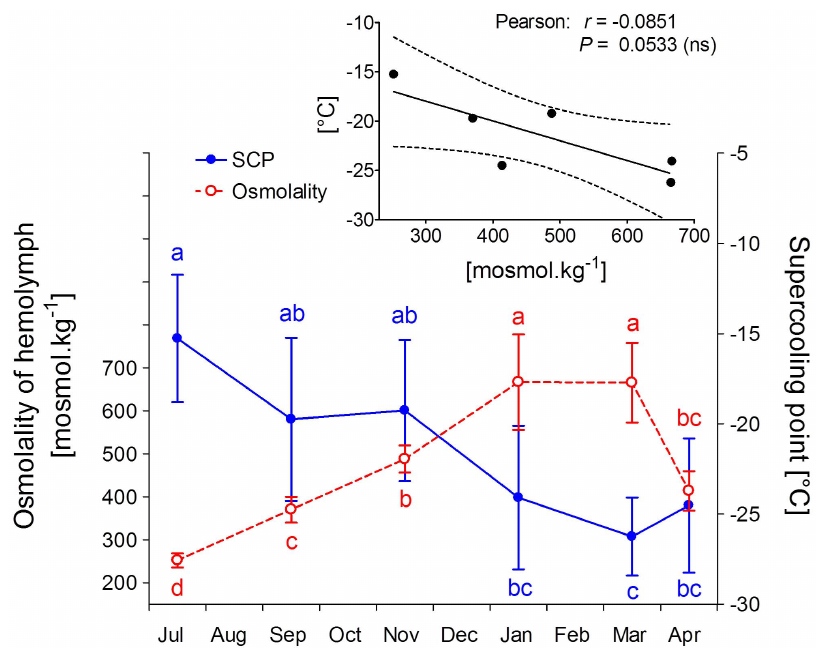
Figure 7. Osmolality and SCP. Seasonal changes of hemolymph osmolality and whole-body supercooling point (SCP) of field-sampled caterpillars of Cydia pomonella during 2010/2011. Each point is the mean 6 S.D. (osmolality, n =10 individuals; SCP, n =8 individuals). Influence of sampling date on parameter was tested by ANOVA followed by Bonferroni’s post hoc test (means flanked with different letters are significantly different). Inset shows that Pearson’s correlation between osmolality and SCP was relatively tight (close to statistical significance).